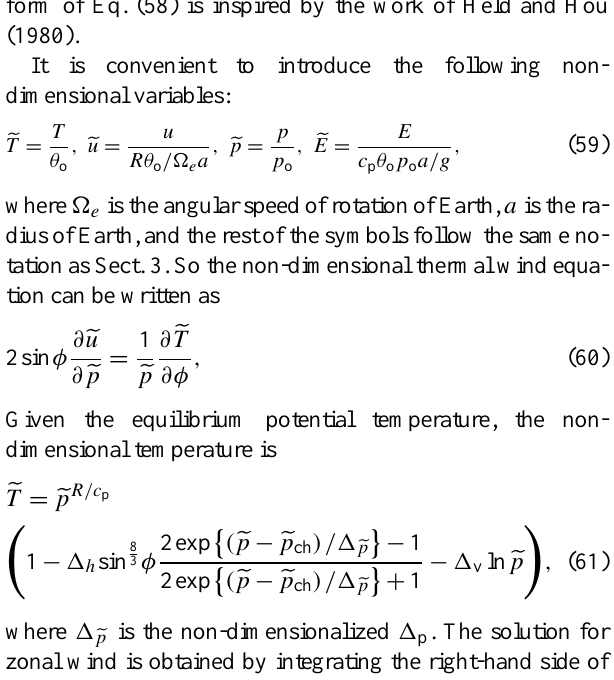
ling the vertical extent of the balanced jet and the other